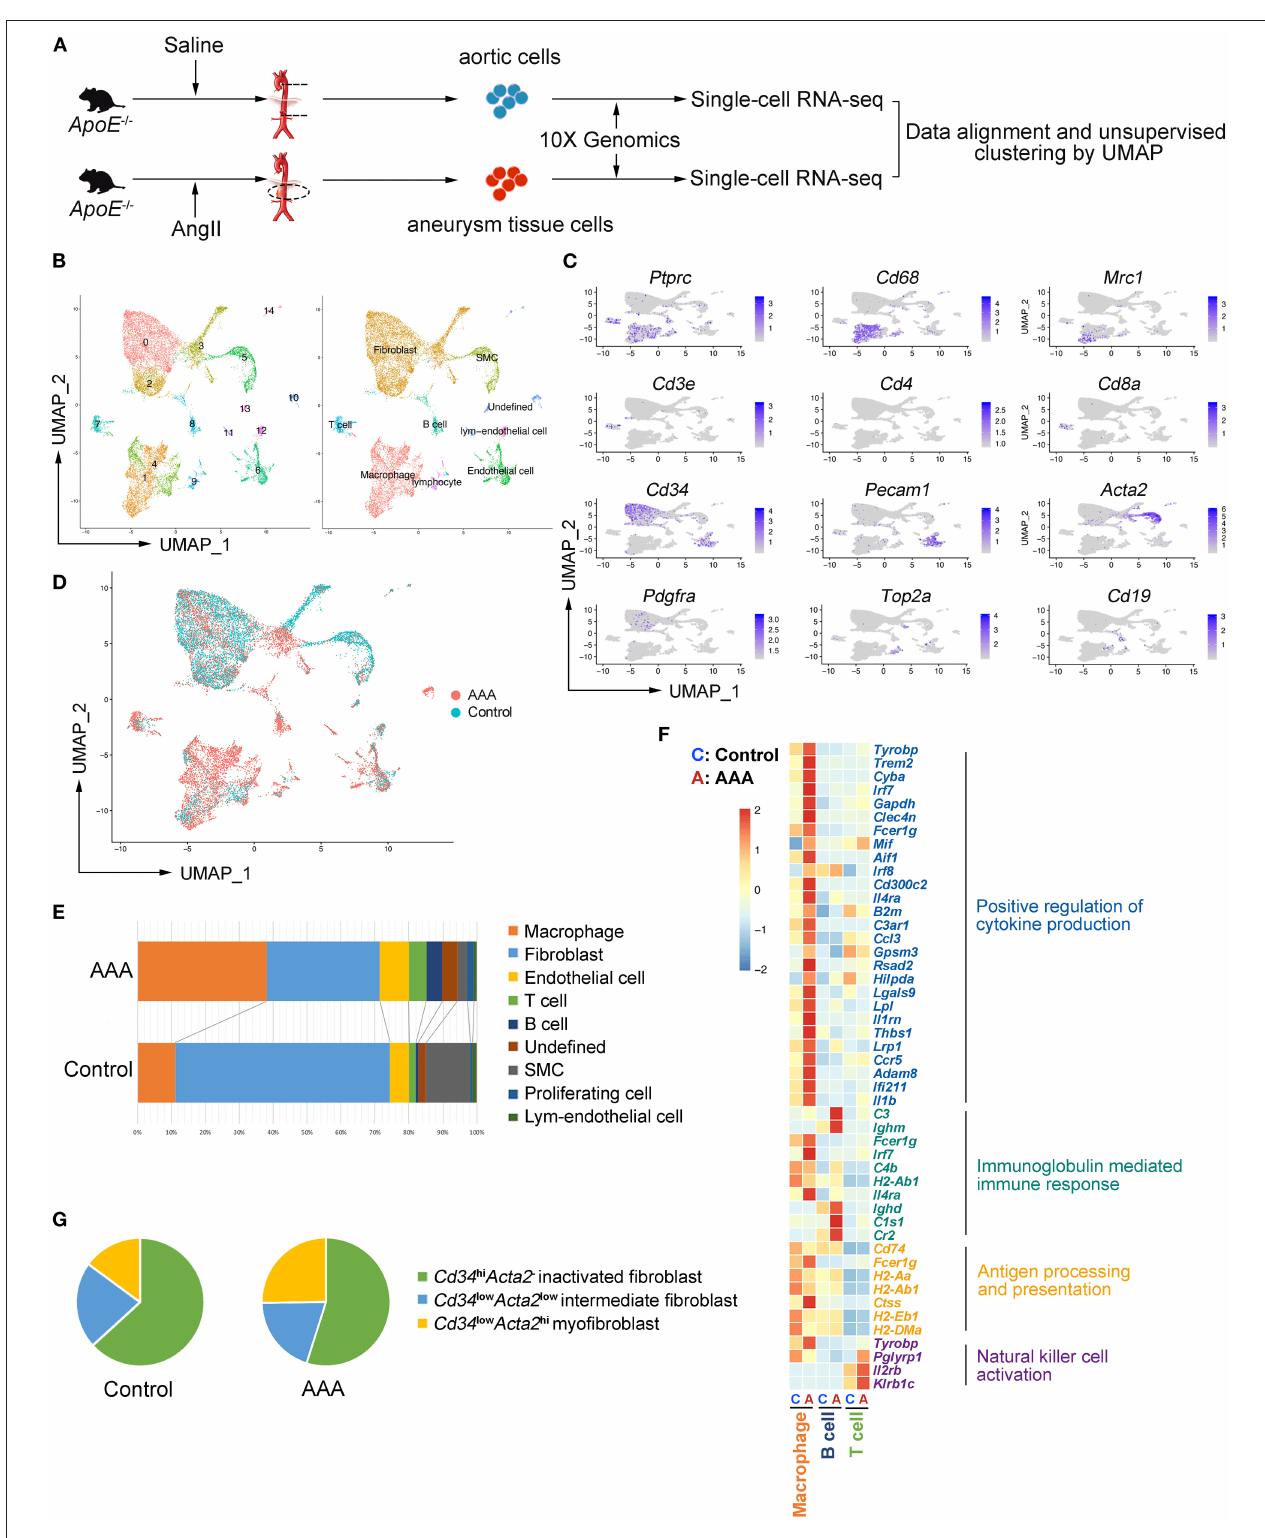
FIGURE 1 | Aortic and aneurysmal cell populations revealed by scRNA-seq. (A) Schematic diagram of the experimental design. (B) Uniform manifold approximation and projection (UMAP) representation of the aligned gene expression data from saline-treated (control, n